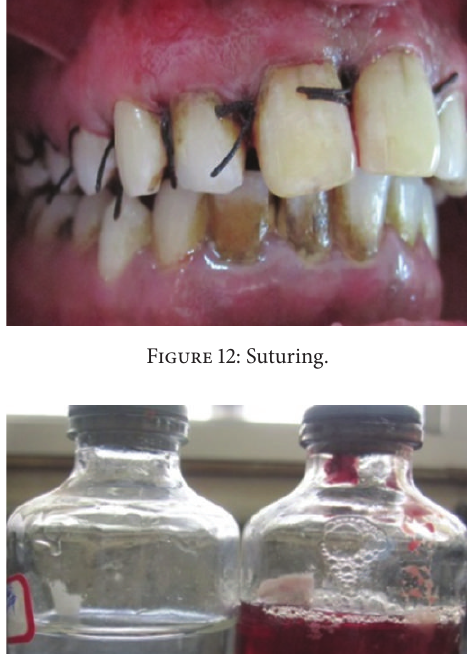
Figure 17: PFM crown cementation on 11, 12, 13, and